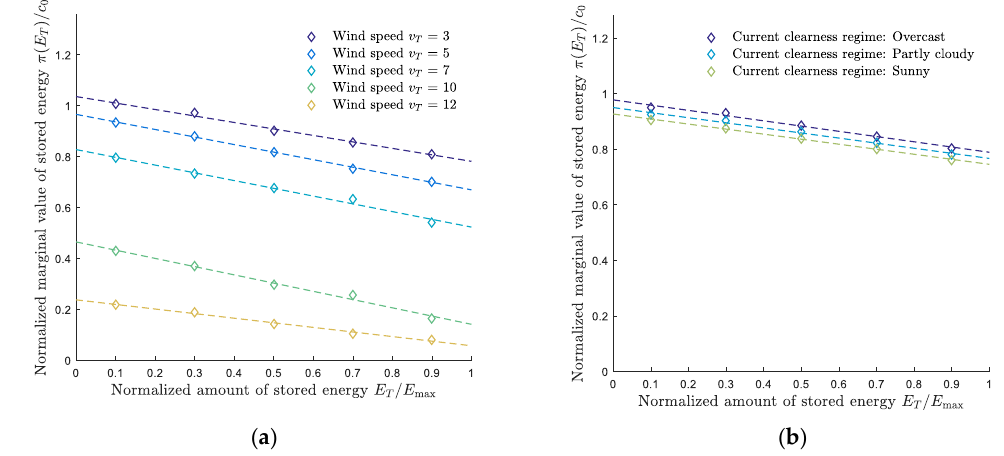
Figure 4. Convergence of value function parameters for different wind speeds for the case of wind power ( a ) and for different cloud cover conditions (clearness regimes) for the case of PV ( b ).